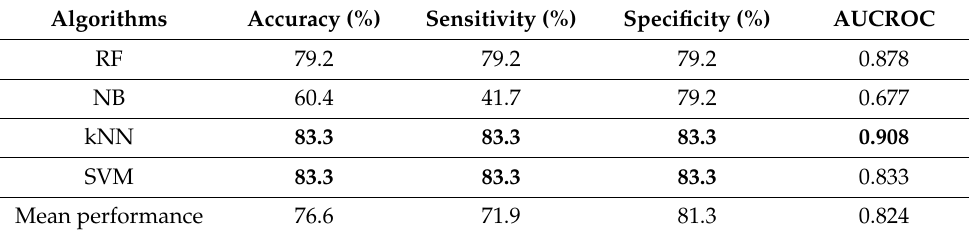
Table 6. Results using MR imaging features after the SMOTE technique in predicting long-term medical outcomes.